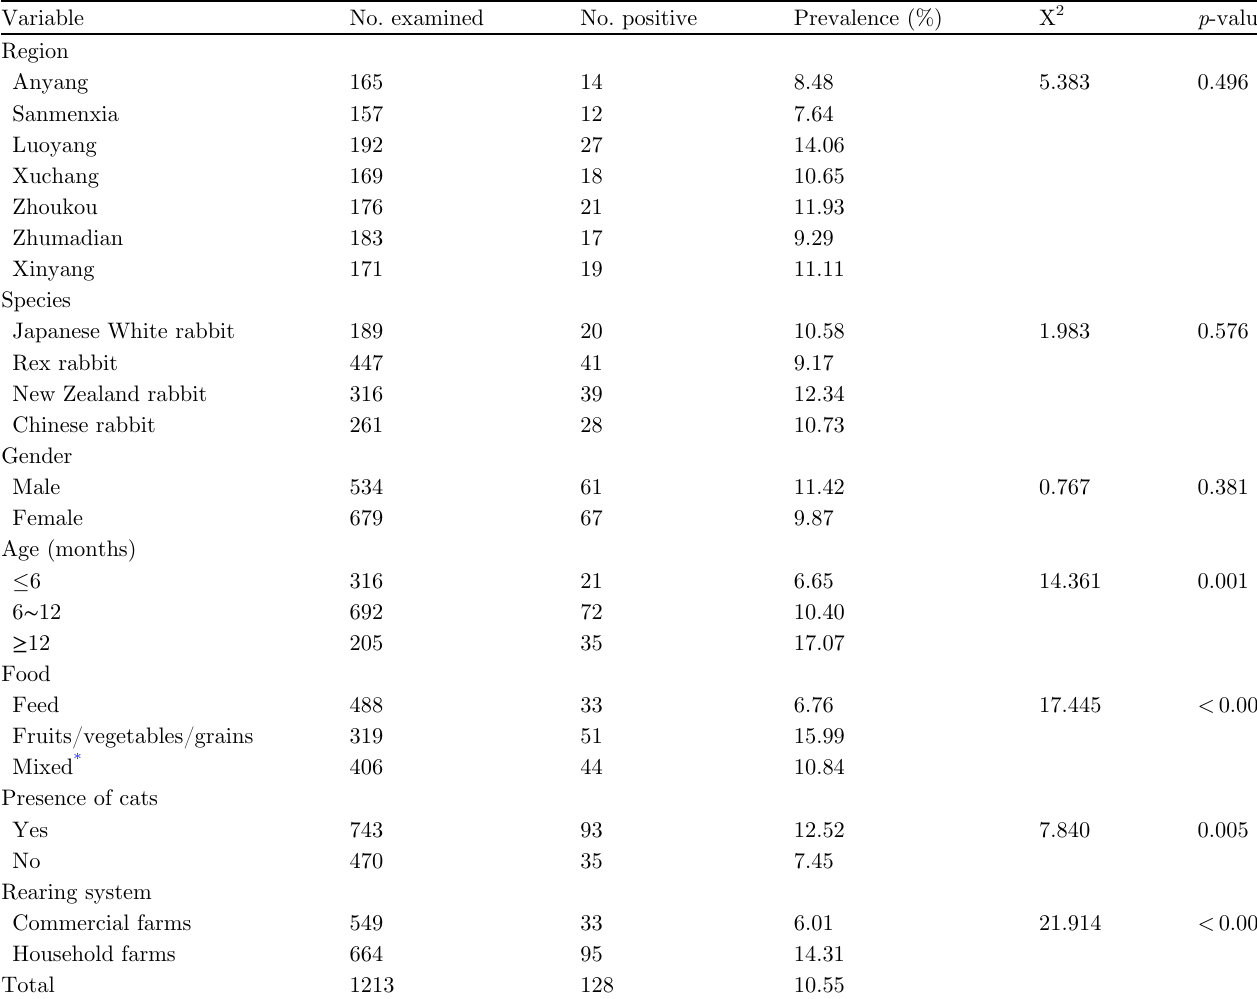
Table 1. Seroprevalence of T. gondii infection in domestic rabbits in Henan province, central China. Variable